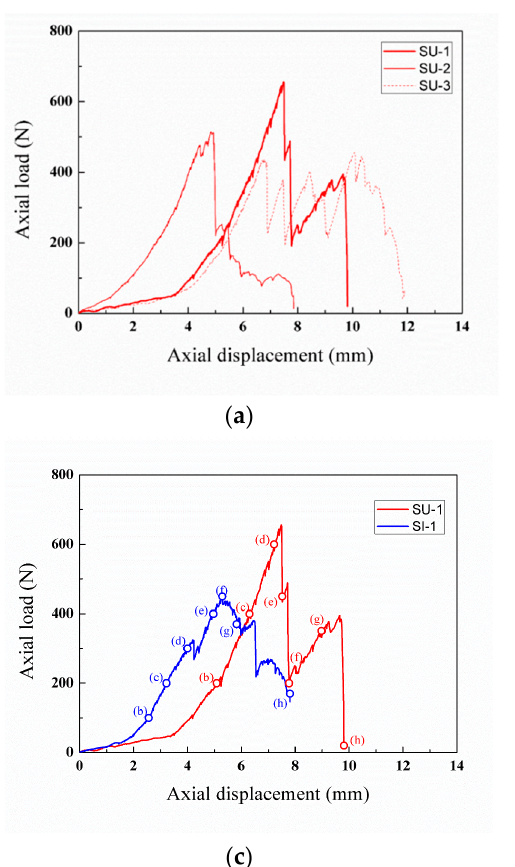
Figure 11. Changes in work during loading.